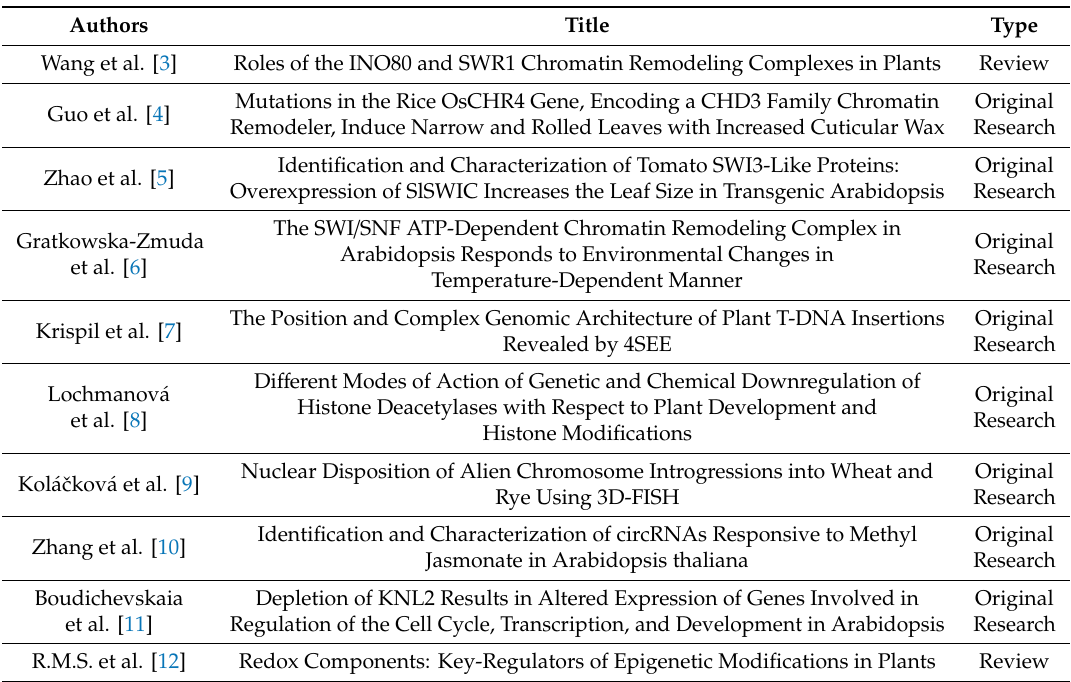
Table 1. Contributors to the special issue “Chromatin, Epigenetics and Plant